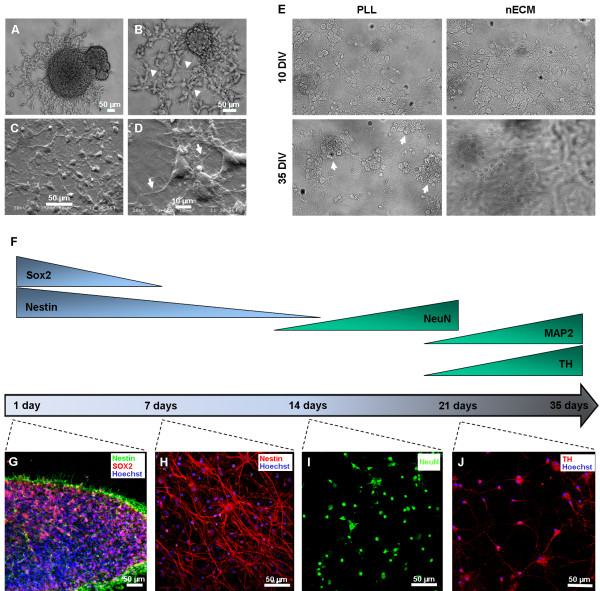
Differentiation of SVZ-derived progenitors on PLL- and nECM-coated coverslips. SVZ-derived neurospheres (at 7 days of proliferation) were seeded on either PLL- or nECM-coated coverslips. (A-B) Images taken by phase contrast microscopy at 24 (A) and 72 h (B) post-differentiation on nECM. Arrowheads in panel B point to the arising neuritic network. Scale bars, 50 μm. (C-D) Analysis by scanning electron microscopy (SEM) 20 days post-differentiation on nECM. Panel D arrows show matrix-embedded neurites. Scale bars, 50 and 10 μm, respectively. (E) Focusing on neurosphere differentiation after 10 or 35 days, cell degeneration (arrowheads) was observed only in the case of PLL substrates at 35 days in culture. (F) Representation of the appearance/disappearance of marker expression throughout differentiation culture. (G-J) Representative images of neurodevelopmental marker expression in SVZ-derived progenitors on nECM-coated coverslips. SVZ neurospheres differentiated on nECM in the presence of the factors shown in Figure 5 were analyzed by immunofluorescence with the following markers: (G) Sox2 (red), Nestin (green), Hoechst (blue); (H) Nestin (red), Hoechst (blue); (I) NeuN (green); (J) MAP2 (red), Hoechst (blue). All images are representative of three independent experiments.